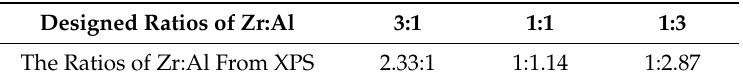
Table 1. The mixing ratios of Zr:Al according to the spectral peak information.